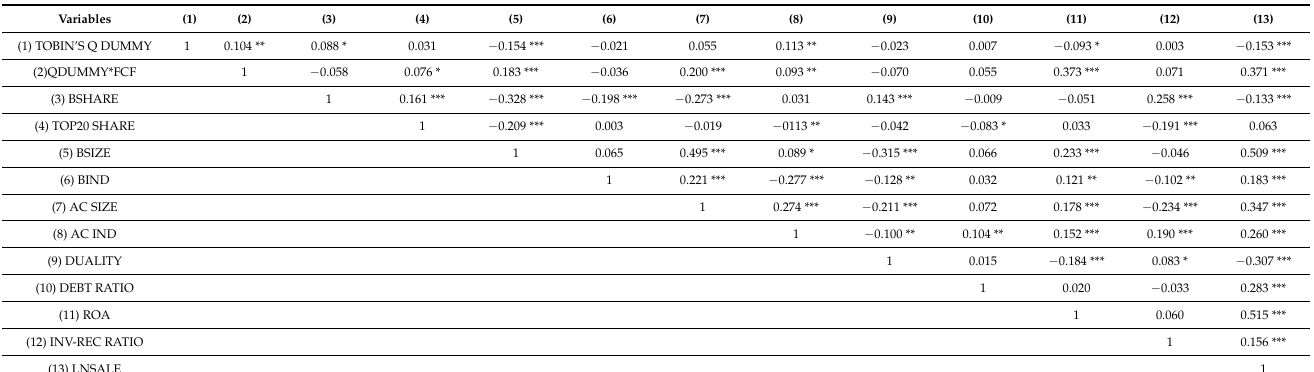
Table 4. Pearson correlation matrix for